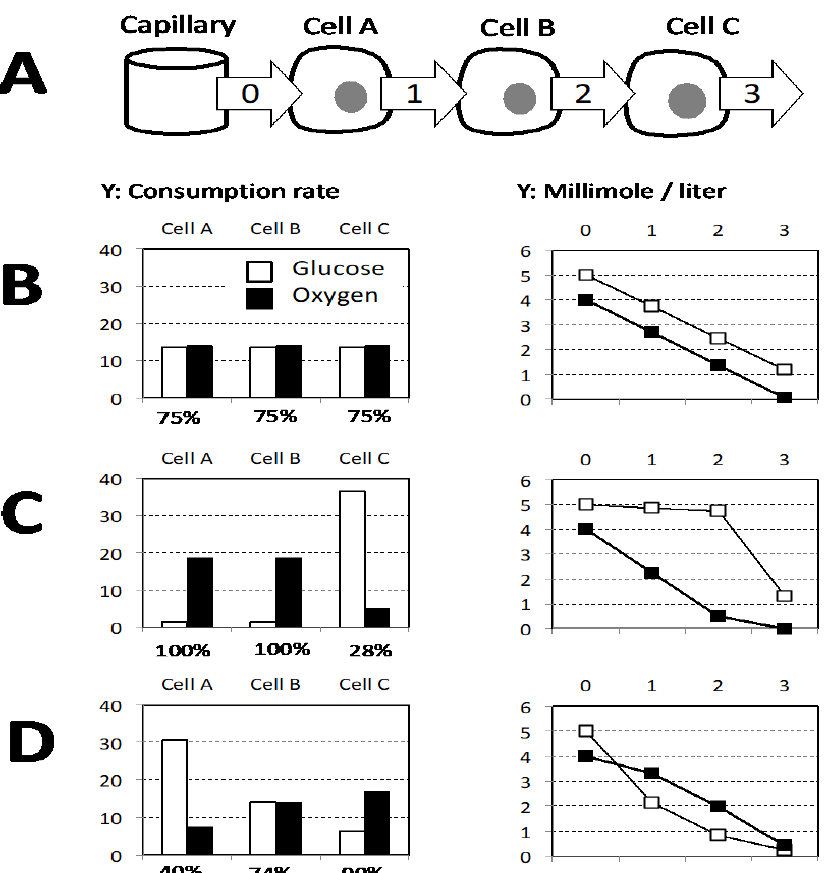
Figure 4. ( A ) The capillary supplies oxygen and glucose and three successive layers of cells with increasing distance from capillary are considered (Cell A, B, C), relevant extracellular sites are figured by arrows that schematize the flux from the capillary to the successive layer of cells. Glucose and oxygen available in the blood are considered to be present immediately outside the capillary (site 0). In the successive sites (1–3) the quantities available are supposed to be determined by the consumption of the previous cell layer. The oxygen supply is supposed to allow a mitochondrial respiration covering 75% of the sum of the cellular ATP needs. ( B – D ) The histograms on the left figure glucose and oxygen consumption rate of each cell layer, the graphs on the right represent the concentrations available in the successive sites (0–3). ( B ) Equal share of oxygen and glucose for the three layers results in a linear decrease of concentrations. ( C ) Respiration is the priority, and then the first two cells (A and B) cover 100% of their ATP need by respiration and the lactic fermentation is restricted to the remote cell C. ( D ) Lactic fermentation is the priority and is considered as proportionate to glucose concentration with a value arbitrarily set to Lactic fermentation flux = 12 × glucose